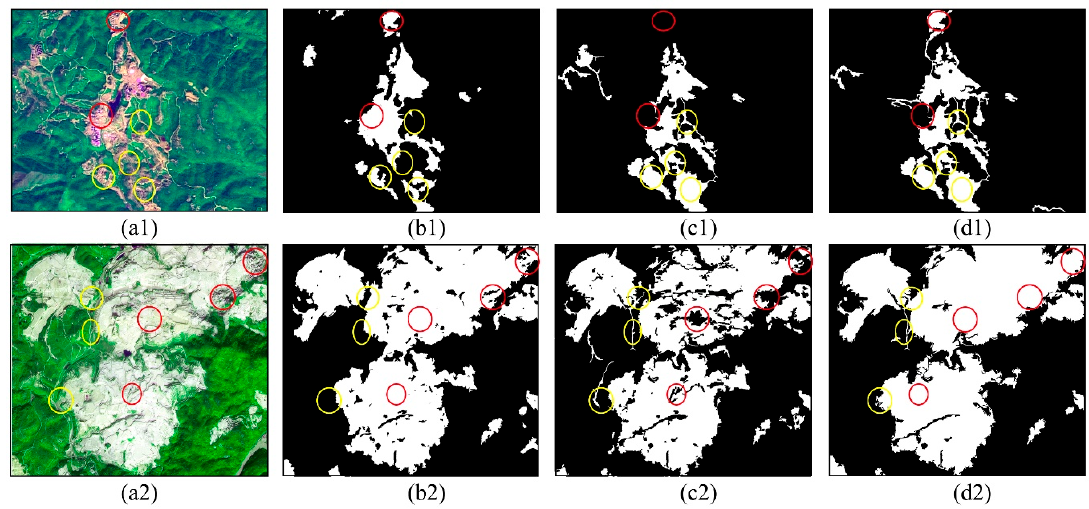
Figure 9. Extracted object contours with different extraction algorithms. ( a1–a2 ) The source image; ( b1–b2 ) the improved GrabCut; ( c1–c2 ) CART; ( d1–d2 ) SVM. Red circles represent missed regions in results of SVM or CART methods; yellow circles represent regions mistakenly classified as REO mining areas in results of SVM or CART methods.